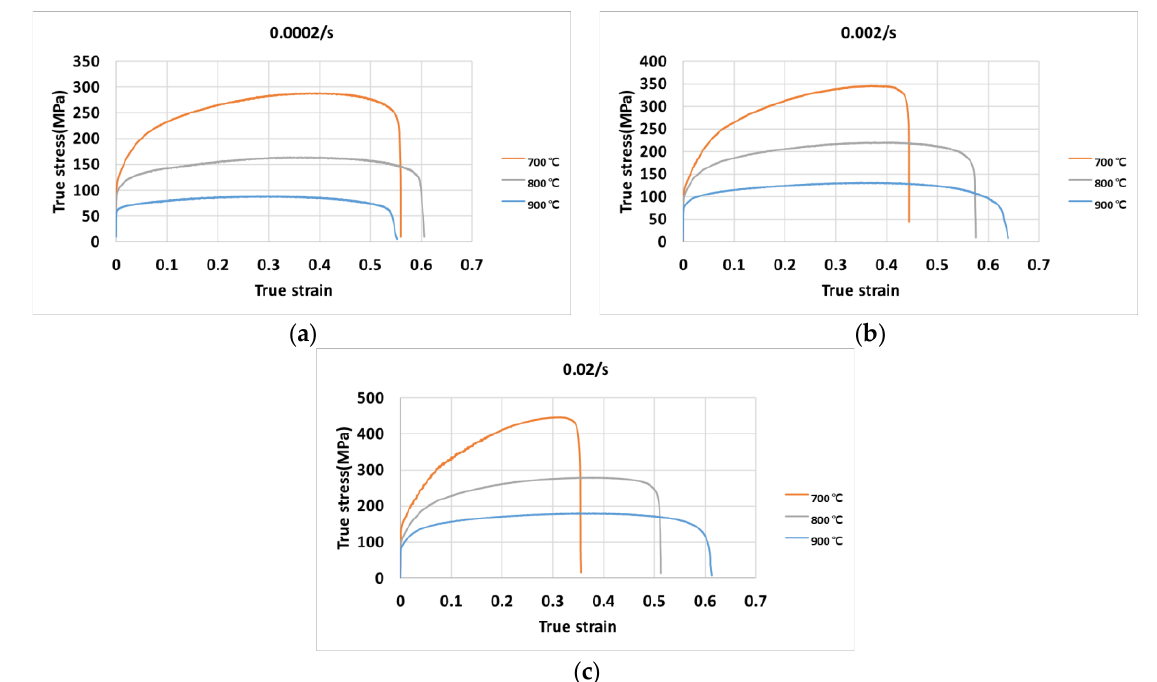
Figure 4. Variation of ( a ) 𝑞 and ( b ) A .